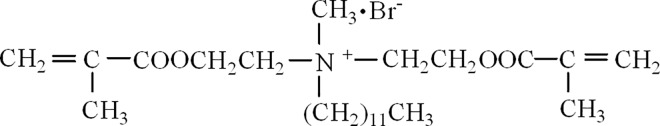
Structure of MAE-DB.